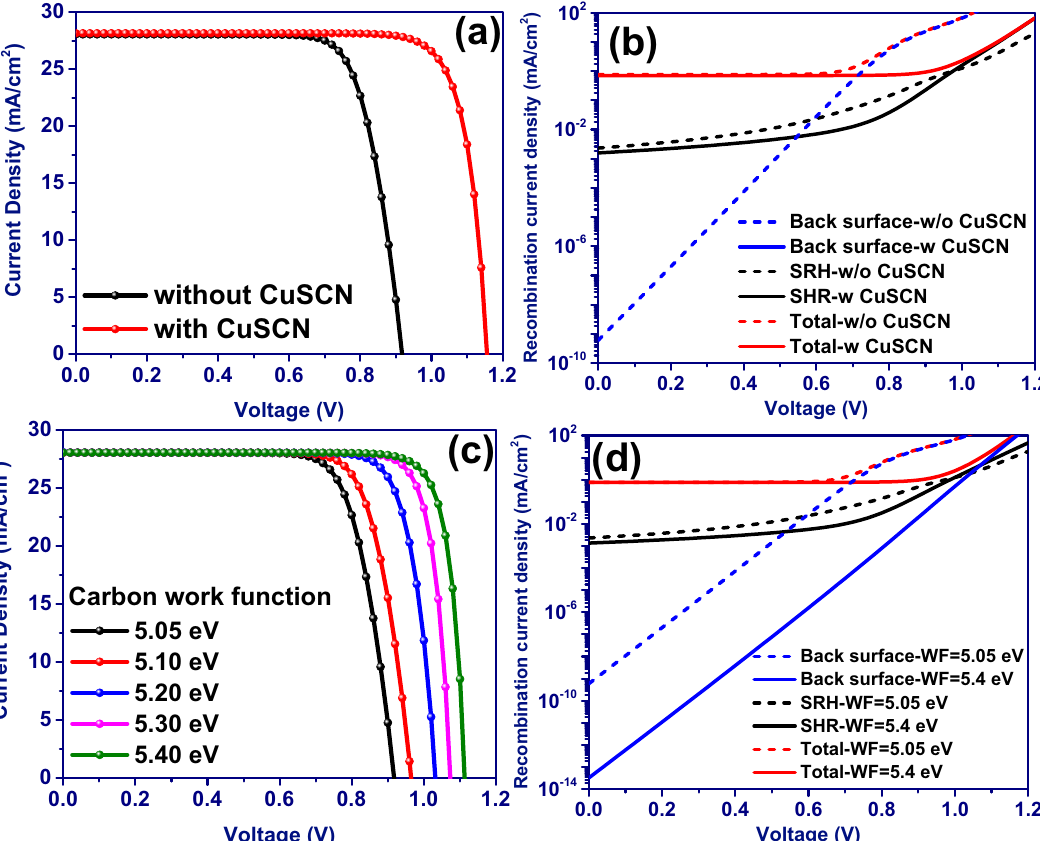
Figure 6. ( a ) J–V characteristics and ( b ) recombination current density of the optimized plasmonic device with and without the CuSCN hole transport layer. ( c ) J–V characteristics and ( d ) recombination current density of the optimized plasmonic device as a function of carbon electrode work function (WF).